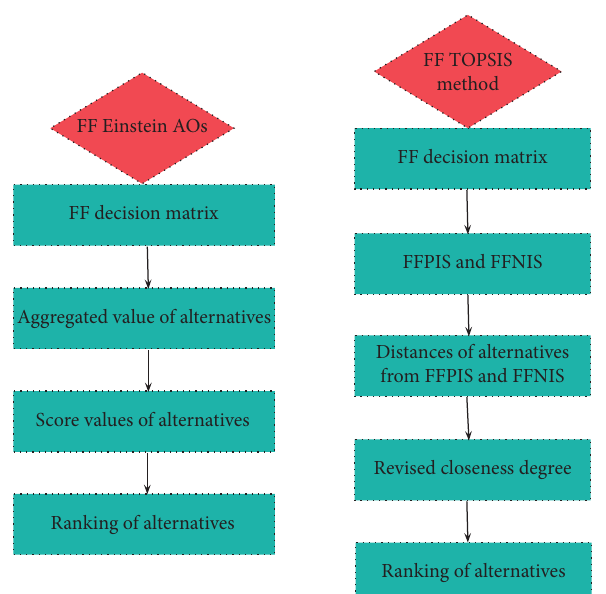
Figure 2: Flow chart for MADM problem using FF Einstein AOs and FF TOPSIS